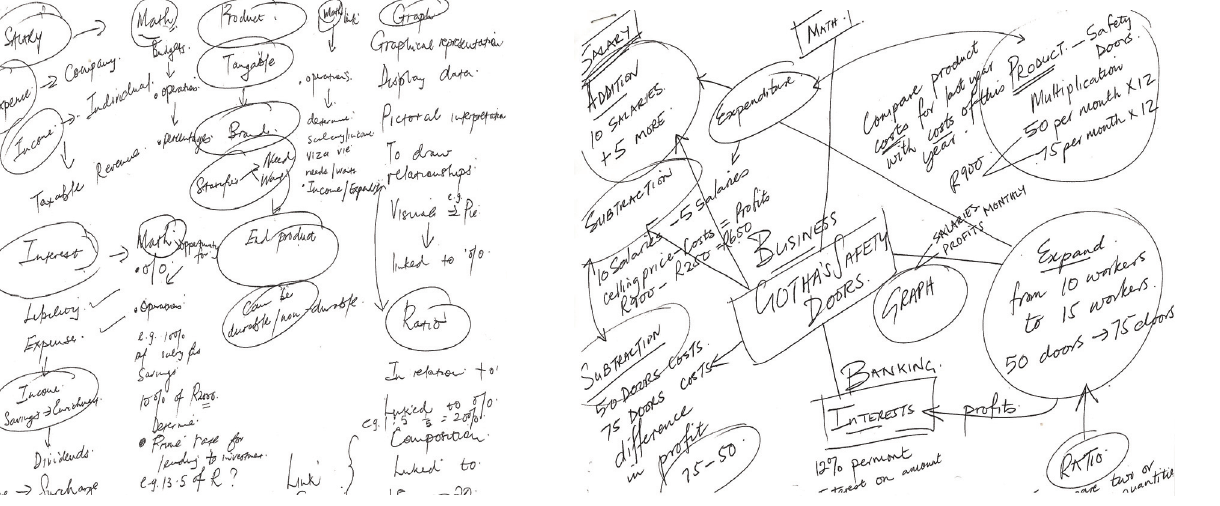
Figure 2: The EMS teacher’s concept map Figure 3 : The Mathematics teacher’s concept